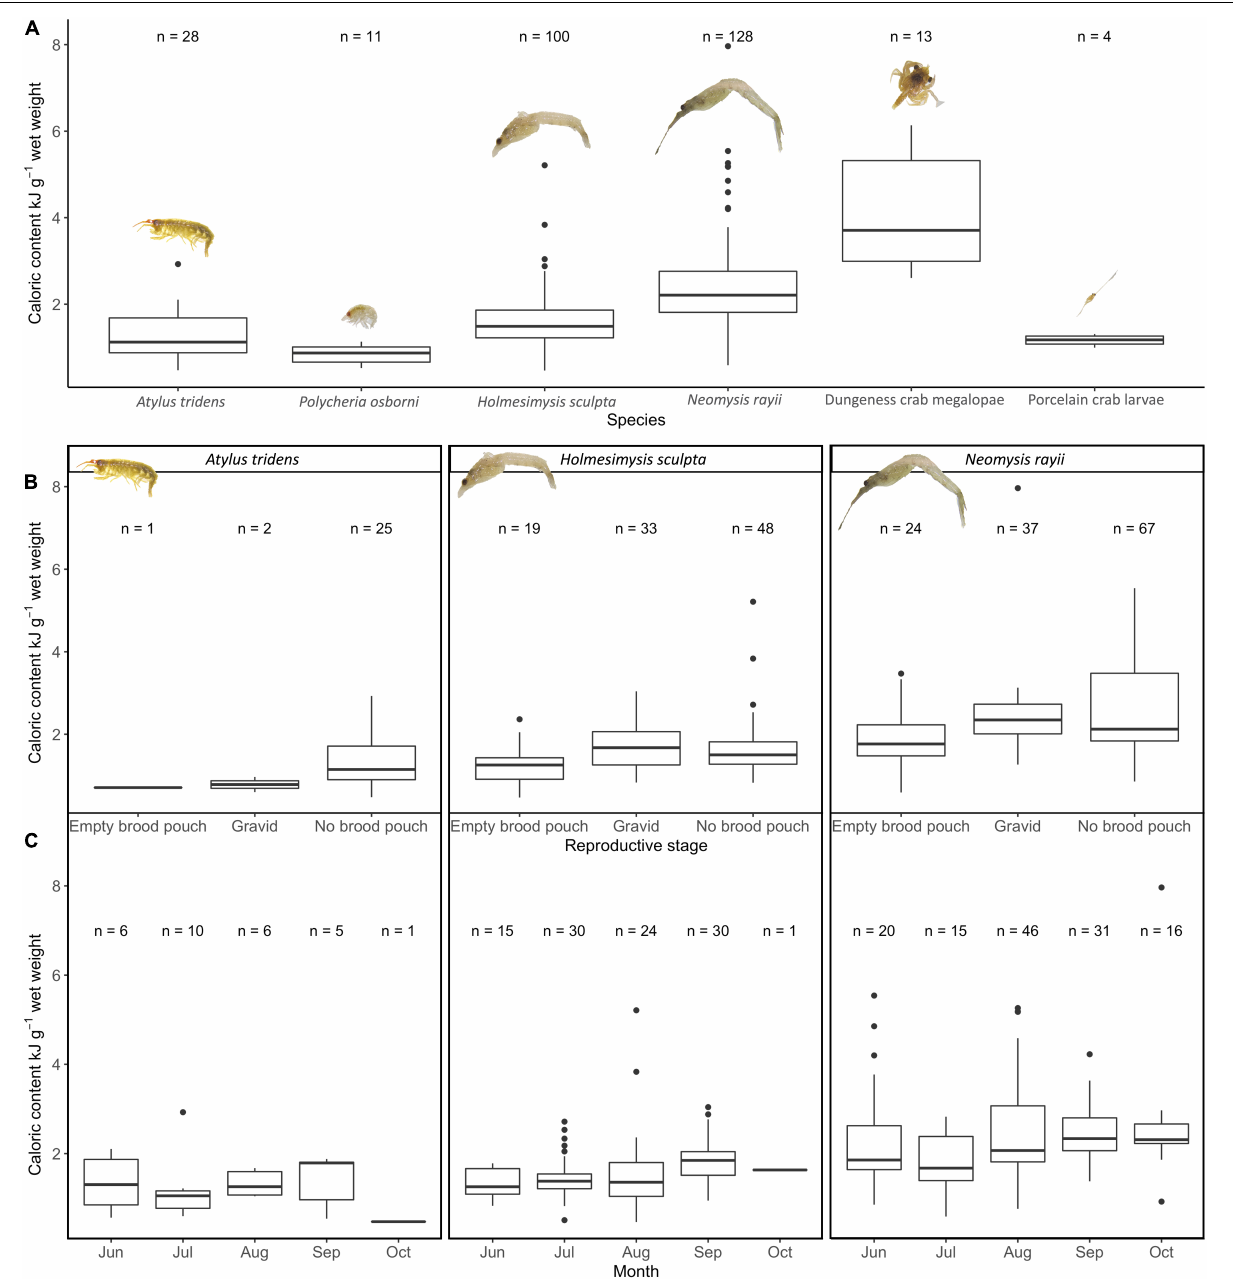
however, not for N. rayii (Kruskal–Wallis χ 2 = 9.49, p = 0.008) nor A. tridens (Kruskal–Wallis χ 2 = 3.35, p = 0.187) ( Figure 2B ). For H. sculpta , females with empty brood pouches had significantly lower caloric values (1.23 ± 0.49 kJ g - 1 ) than gravid females (1.74 ± 0.58 kJ g - 1 ; Dunn’s test, p = 0.0007), but not than individuals with no brood pouch (1.65 ± 0.73 kJ g - 1 ;